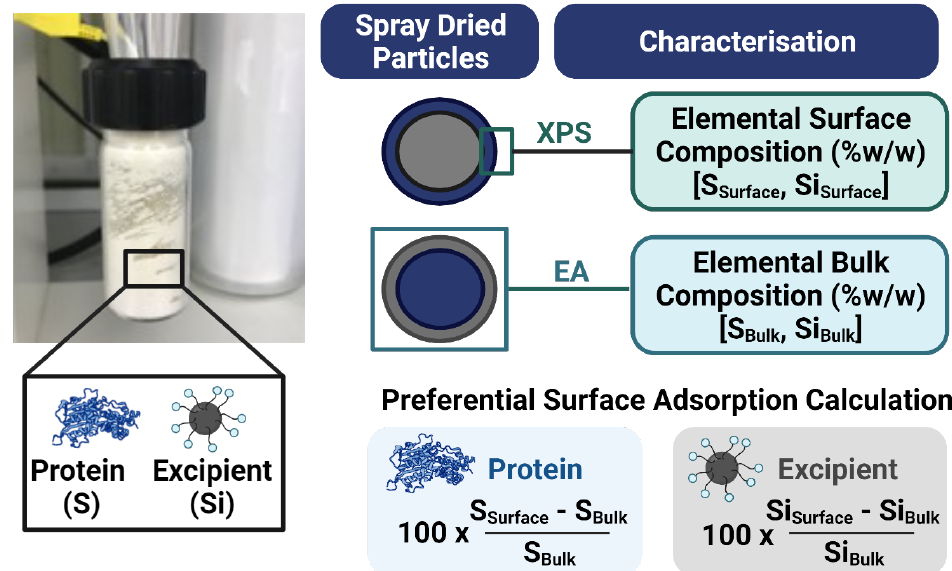
Figure 4. Procedure overview for evaluating relative extent of component preferential surface adsorption in protein particles co-spray-dried with nanoparticle excipients. Protein composition in particle surface and bulk are monitored via sulphur (S) content. Excipient composition is monitored by silicon (Si)